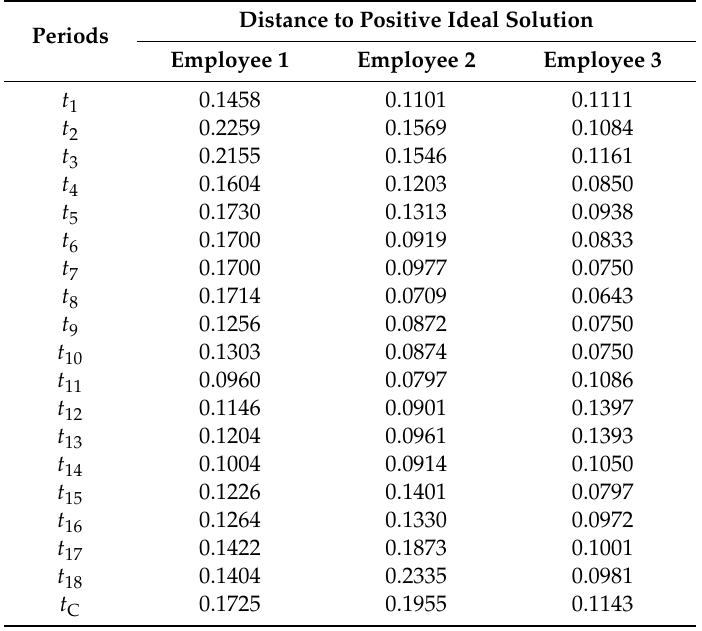
Table 11. Distances between the performance of employees and the positive ideal solution.